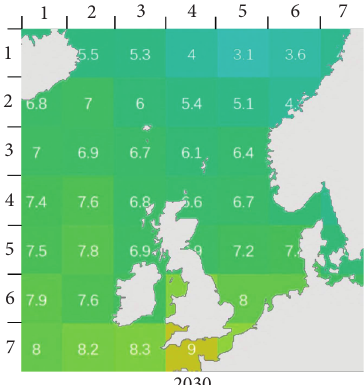
Figure 14: The predicted annual average sea.